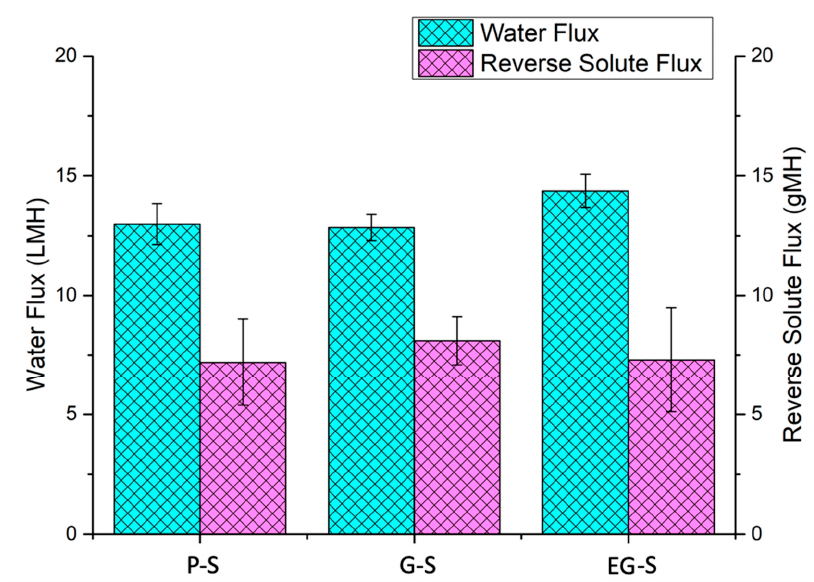
Figure 3. Water fluxes and reverse solute fluxes for P-S, G-S, and EG-S spacers.